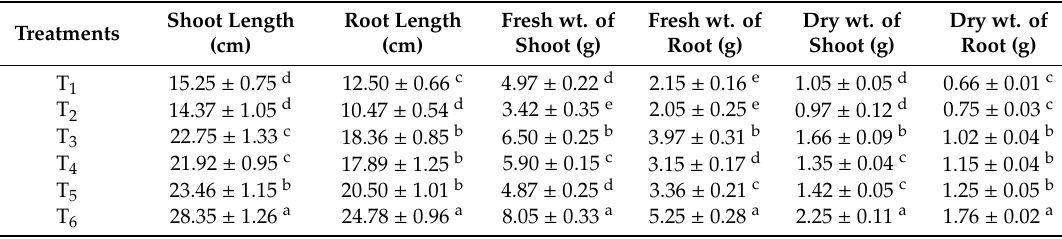
Table 3. E ff ect of seed biopriming with Pseudomonas geniculata MF-84 on plant growth attributes in maize at 30 days of sowing under nethouse